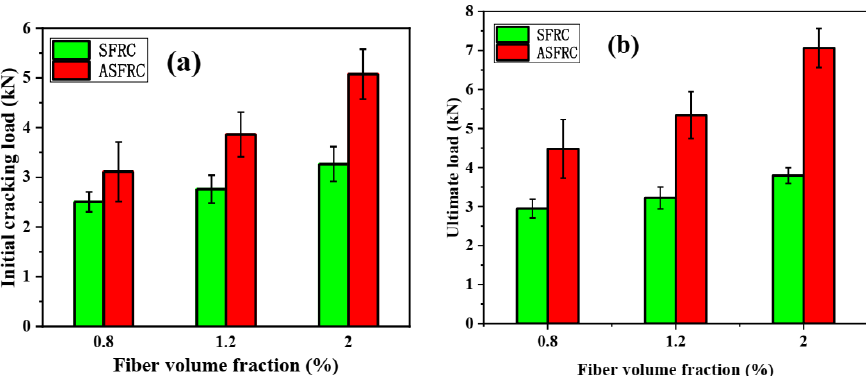
Figure 2. Initial cracking load and ultimate load of ASFRC and SFRC specimens with different fiber volume fractions: ( a ) Initial cracking load and ( b ) Ultimate load.